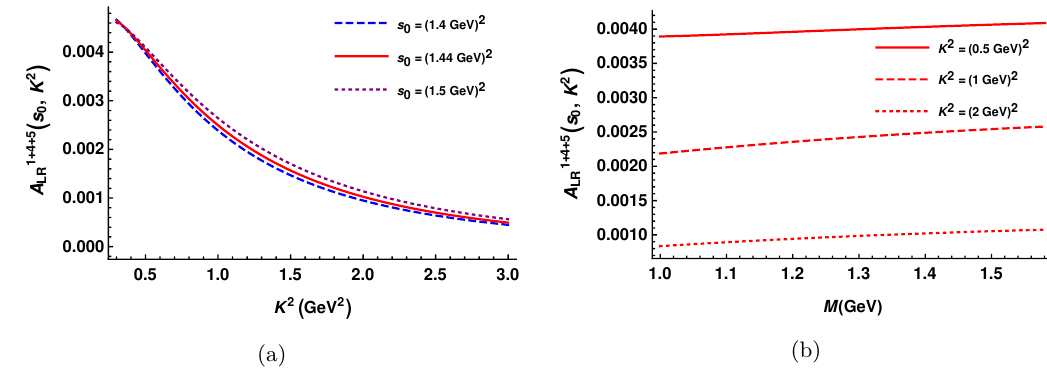
, F 4 and Figure 9 . The physical FF, A LR ( s 0 , K 2 ) is calculated from the combination of F 1 LR LR employing proton DAs. Left panel: A 1+4+5 ( s = 2 ) vs K 2 is shown for three values of s F 5 0 , K 0 LR LR (1 . 4 GeV ) 2 (violate dotted), s = (1 . 44 GeV ) 2 (red solid) and s = (1 . 5 GeV ) 2 (blue dashed) at 0 0 the Borel Mass, M 2 = 2 GeV 2 . Right Panel: A 1+4+5 ( s 2 ) vs M is shown for three values 0 , K LR of K 2 = 0 . 5 GeV 2 (red solid), K 2 = 1 GeV 2 (red dashed) and K 2 = 2 GeV 2 (red dotted) at the continuum threshold, s = (1 . 44 GeV ) 2 . 0